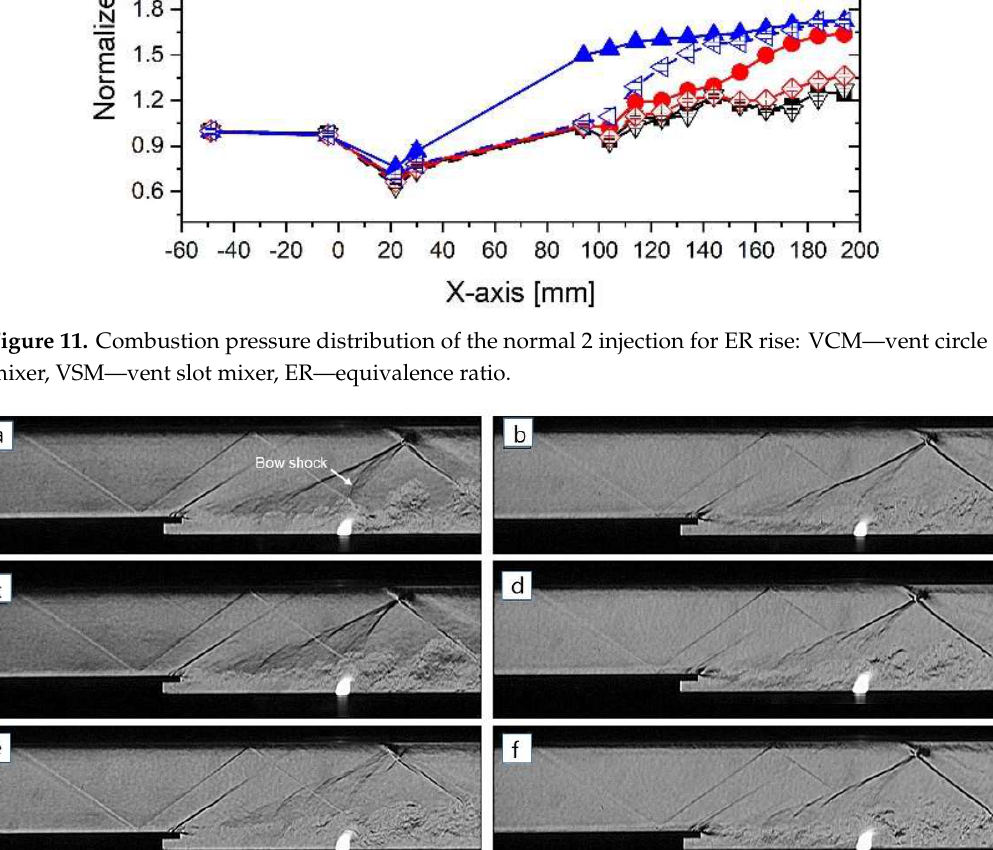
Figure 12. Flow structure transition of the normal 2 injection for ER rise: vent slot mixer ( a , c , e ) and vent circle mixer ( b , d , f ).